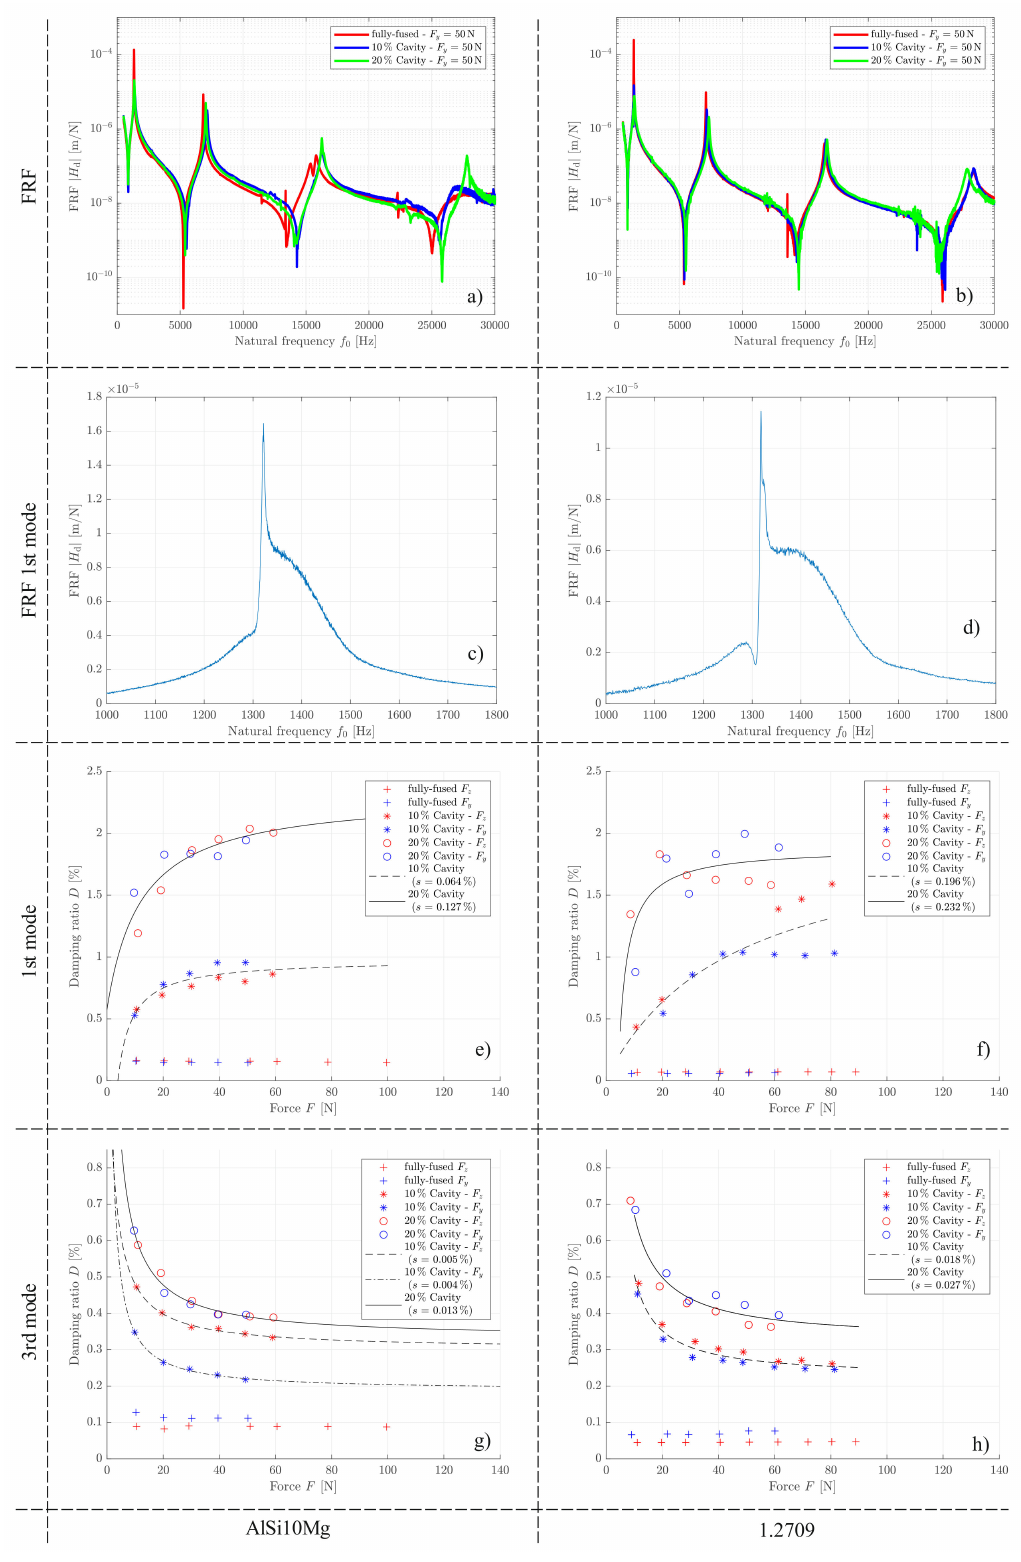
Figure 10. Frequency response functions and force-dependent damping characteristics (1st, 3rd and 5th mode) Left: outer dimensions: 10 × 10 × 200 mm 3 , parameter 12–14, material: AlSi10Mg, right: outer dimensions: 8.4 × 8.4 × 169 mm 3 , parameter 43–45, material: